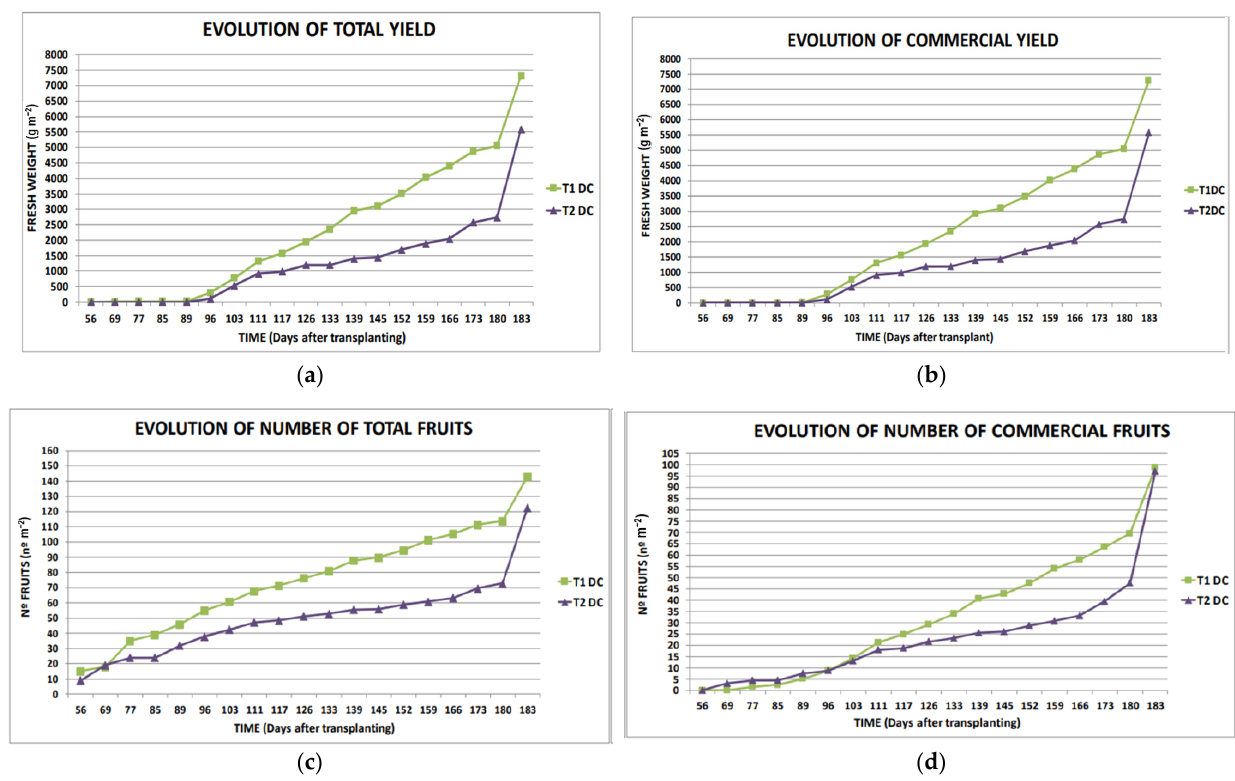
Figure 9. Yield of tomato crops grown in coconut fiber above PVC trays: ( a , b ) evolution of fresh weight accumulated of total and commercial fruits; ( c , d ) evolution of the total and commercial accumulated number of fruits.